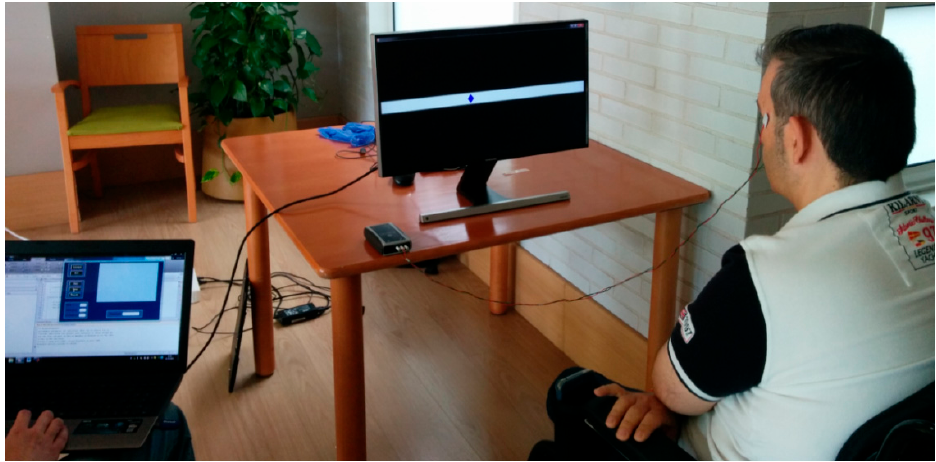
Figure 8. Setup for testing the application software with the BlueGain bioamplifier on the table.